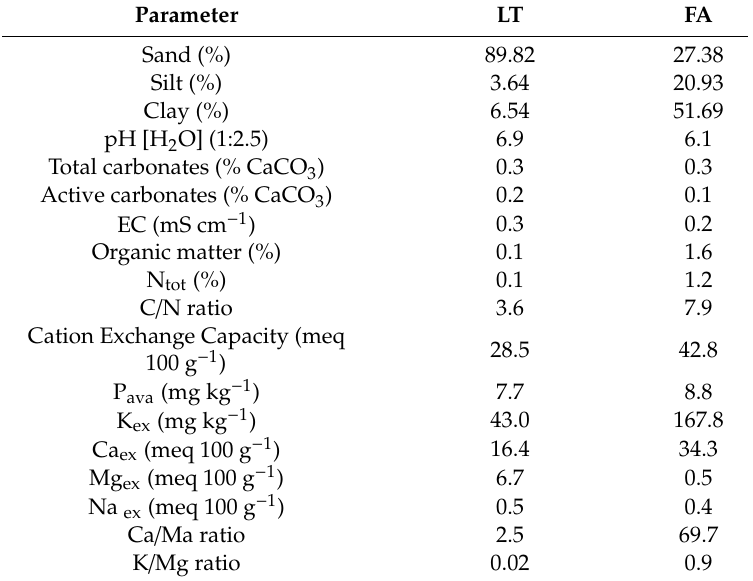
Table 1. Main physical and chemical characteristics of the olive orchard soils of first experiment at Lamezia Terme ( LT ) and the second experiment at Feroleto antico ( FA ).